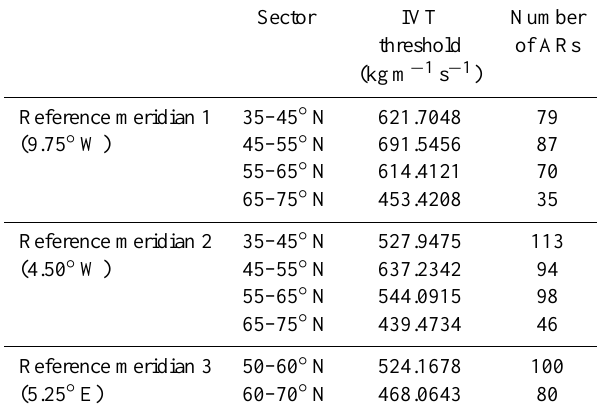
Table 1. The vertically integrated horizontal water vapour trans- port (IVT) threshold and the number of persistent atmospheric rivers detected for each different reference